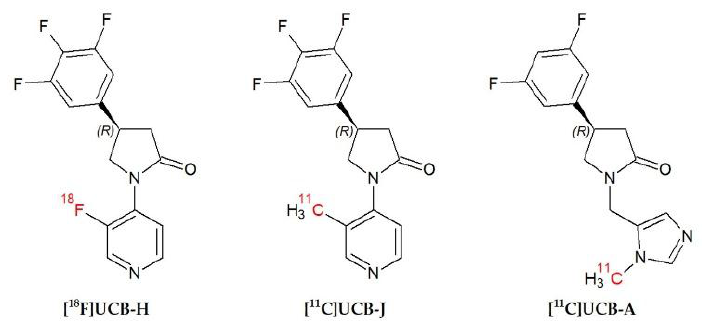
18 F]UCB-H, [ 11 C]UCB-J and [ 11